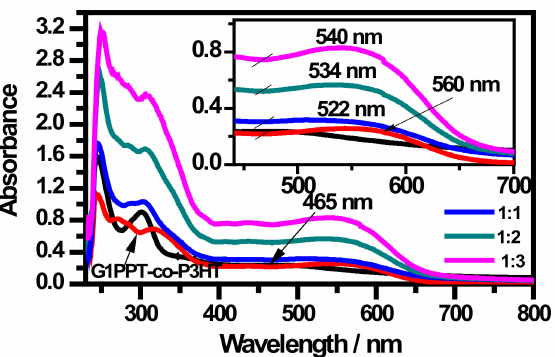
Figure 7. UV-Vis absorption of G1PPT-co-P3HT/PDI-co-Carbazole at different ratio [1]. G1PPT-co-P3HT/PDI-co-Carbazole different bulk heterojunction blended